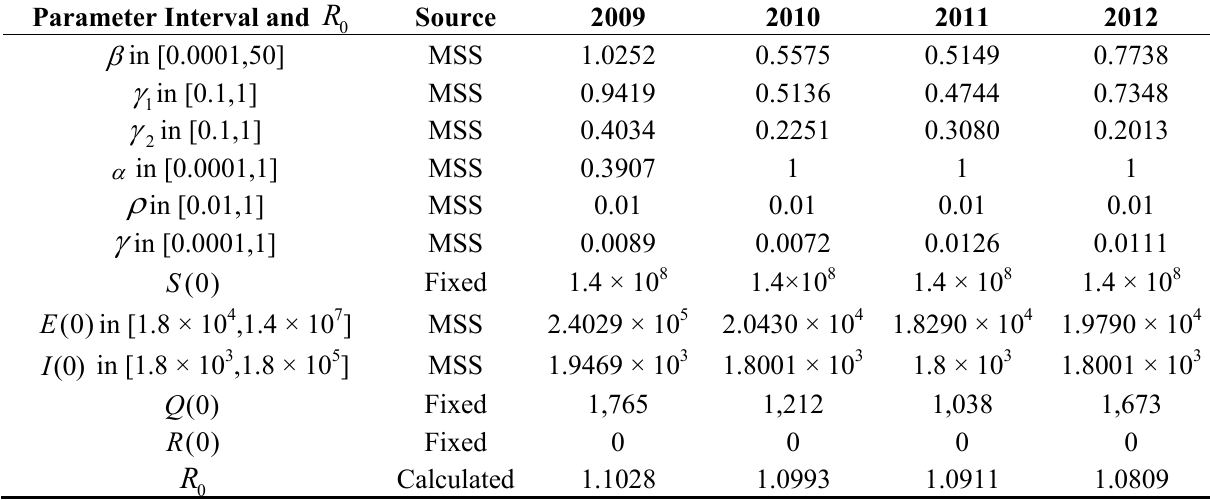
Table 2. Estimation of parameters and the basic reproduction number from 2009 to 2012. Parameter Interval and 0